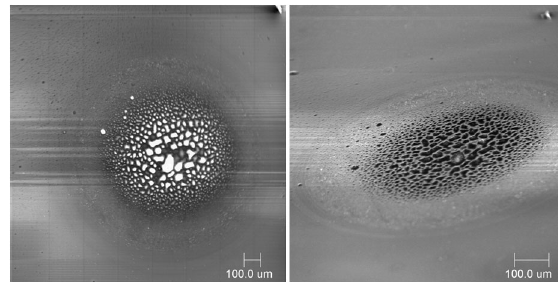
FIG. 6. SEM micrographs of the central damage area at differ- ent substrate inclination